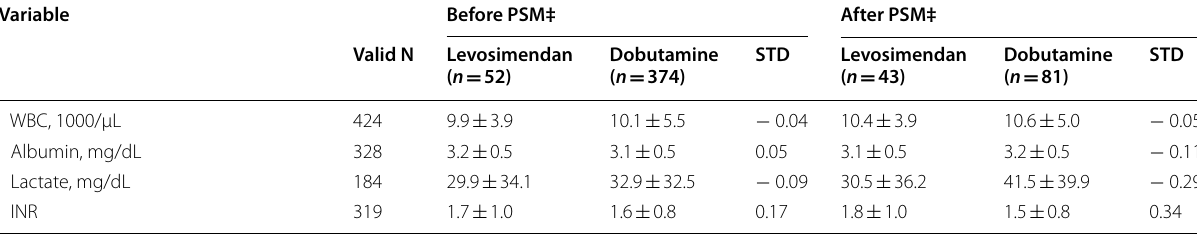
30 who received levosimendan versus dobutamine alone ≥